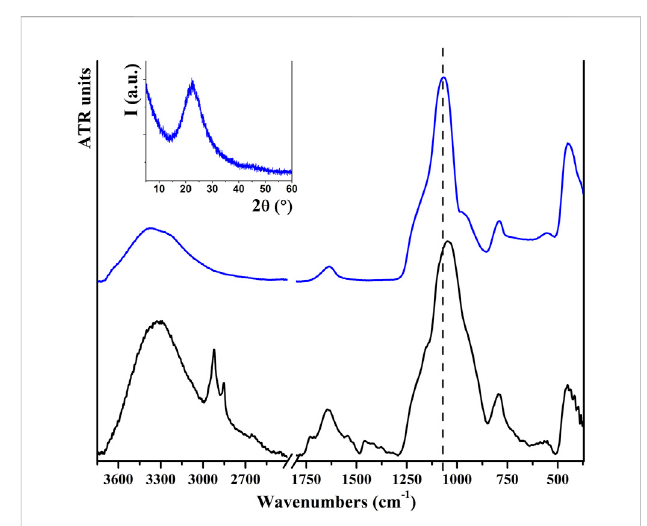
FIGURE 2 FT-ATR spectra of rice husks (black) and the product obtained after acid digestion (blue). Inset shows the PXRD pattern of the obtained SiO 2